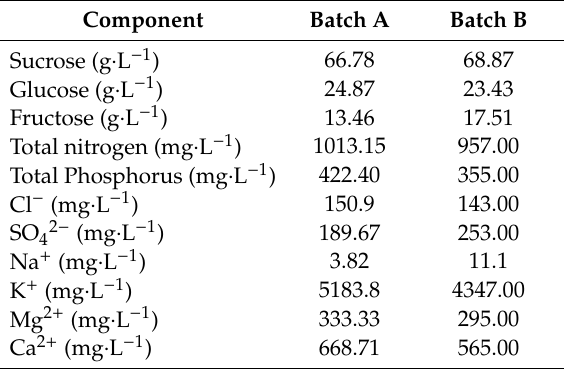
Table 1. Chemical composition of two di ff erent batches of sweet sorghum